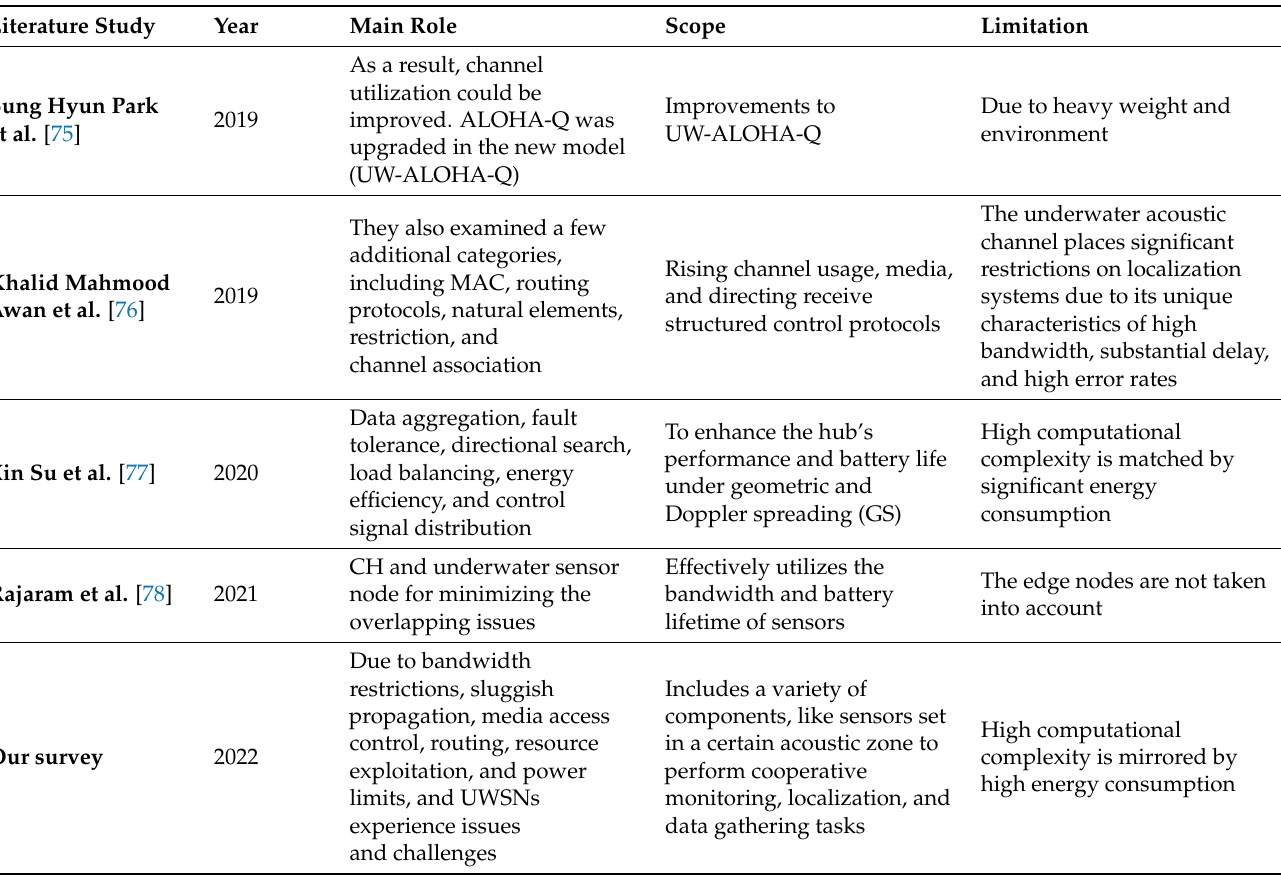
Table 5. Scope for future work in